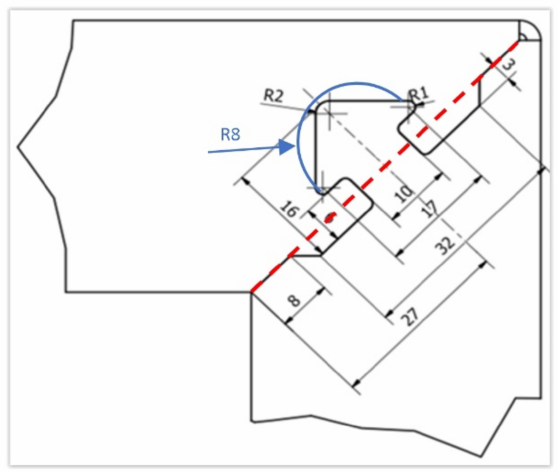
Figure 7. Basic concepts of lock dimensions—essential dimensions of the lock and specific dimensions of different lock tips.